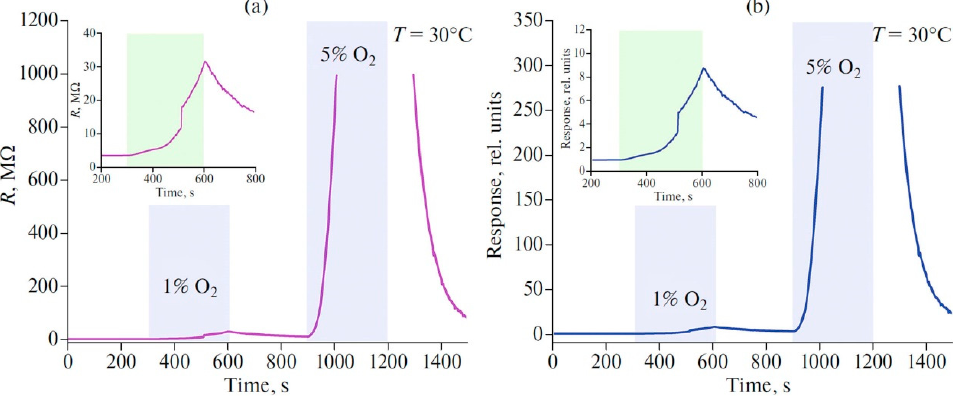
Figure 7. ( a ) Change in the resistance of the receptor material of the Ti2CTx coating when puffing gas mixture with 1 and 5% O 2 and ( b ) the corresponding responses in rel. units /R; operating tem- perature 30 °C. Reprinted with permission from [101]. Copyright 2022: E.P. Simonenko et